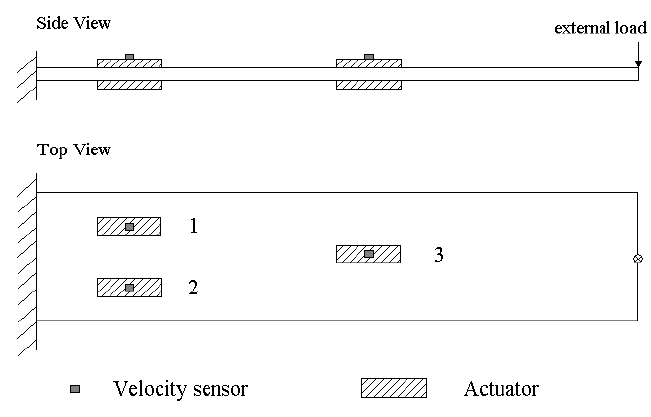
Fig. 3. The configuration of an actively controlled cantilever